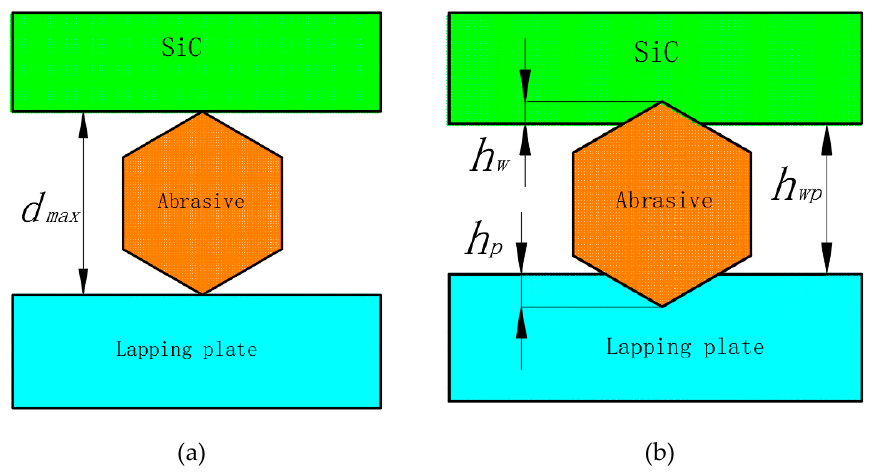
Figure 10. Contact state diagram of the abrasives, workpiece, and lapping plate. ( a ) Ideal contact state. ( b ) Actual contact state.